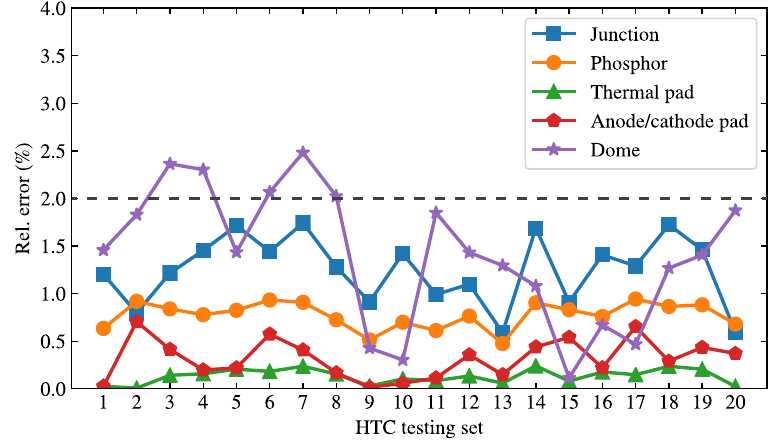
Figure 8. Relative errors in the steady-state ∆ T of the LED CTM, compared to the LED detailed model, for each of the twenty HTC testing sets. The dashed line indicates the 2% junction temperature error requirement of the Delphi4LED end-user specifications